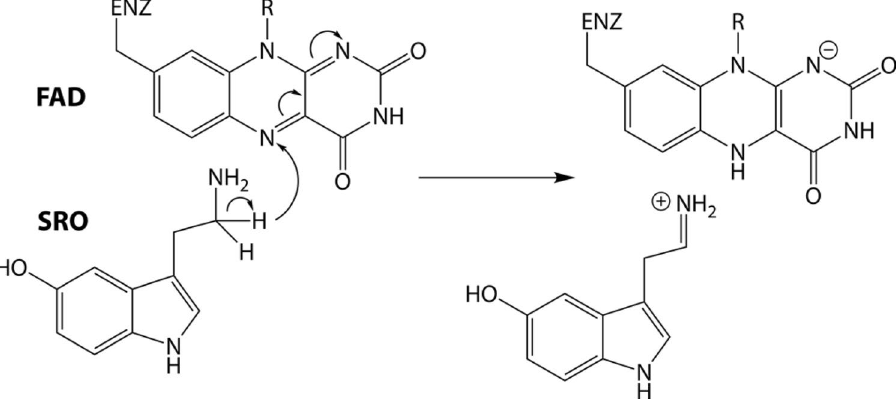
Figure 2. Scheme of the rate-limiting step of MAO-catalyzed serotonin degradation—hydride transfer between the reacting carbon atom of serotonin (SRO) vicinal to the amino group, to the nitrogen atom of the flavin adenine dinucleotide (FAD) cofactor inside the MAO active